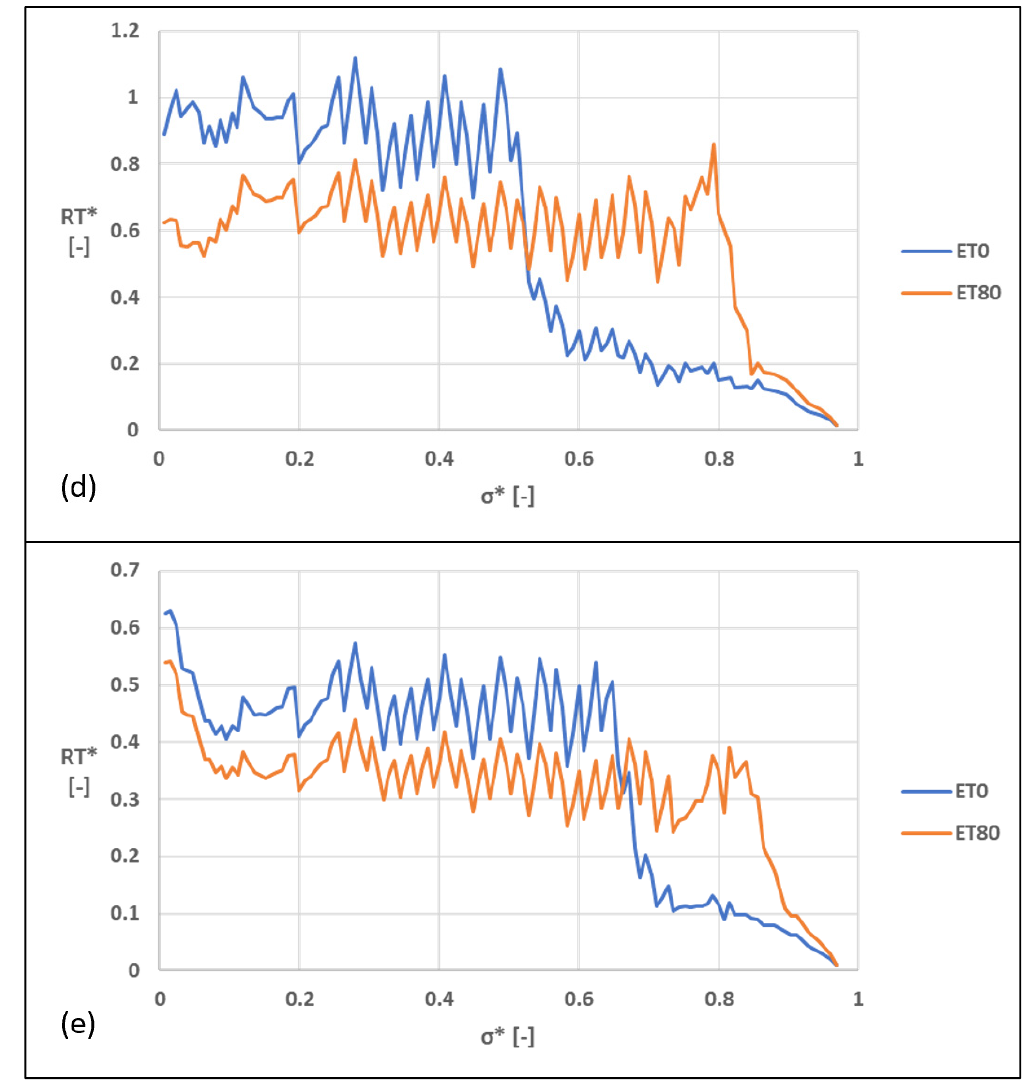
Figure 8. Moving 5-particle average RT* as a function of regional groundwater flux ( J y/x ; positive for gaining, negative for losing) and initial particle placement along the upstream half of the central meander bend. Comparing ET0 and ET80 scenarios for ( a ) J + 2, ( b ) J + 1, ( c ) J0, ( d ) J − 1, and ( e ) J − 2.